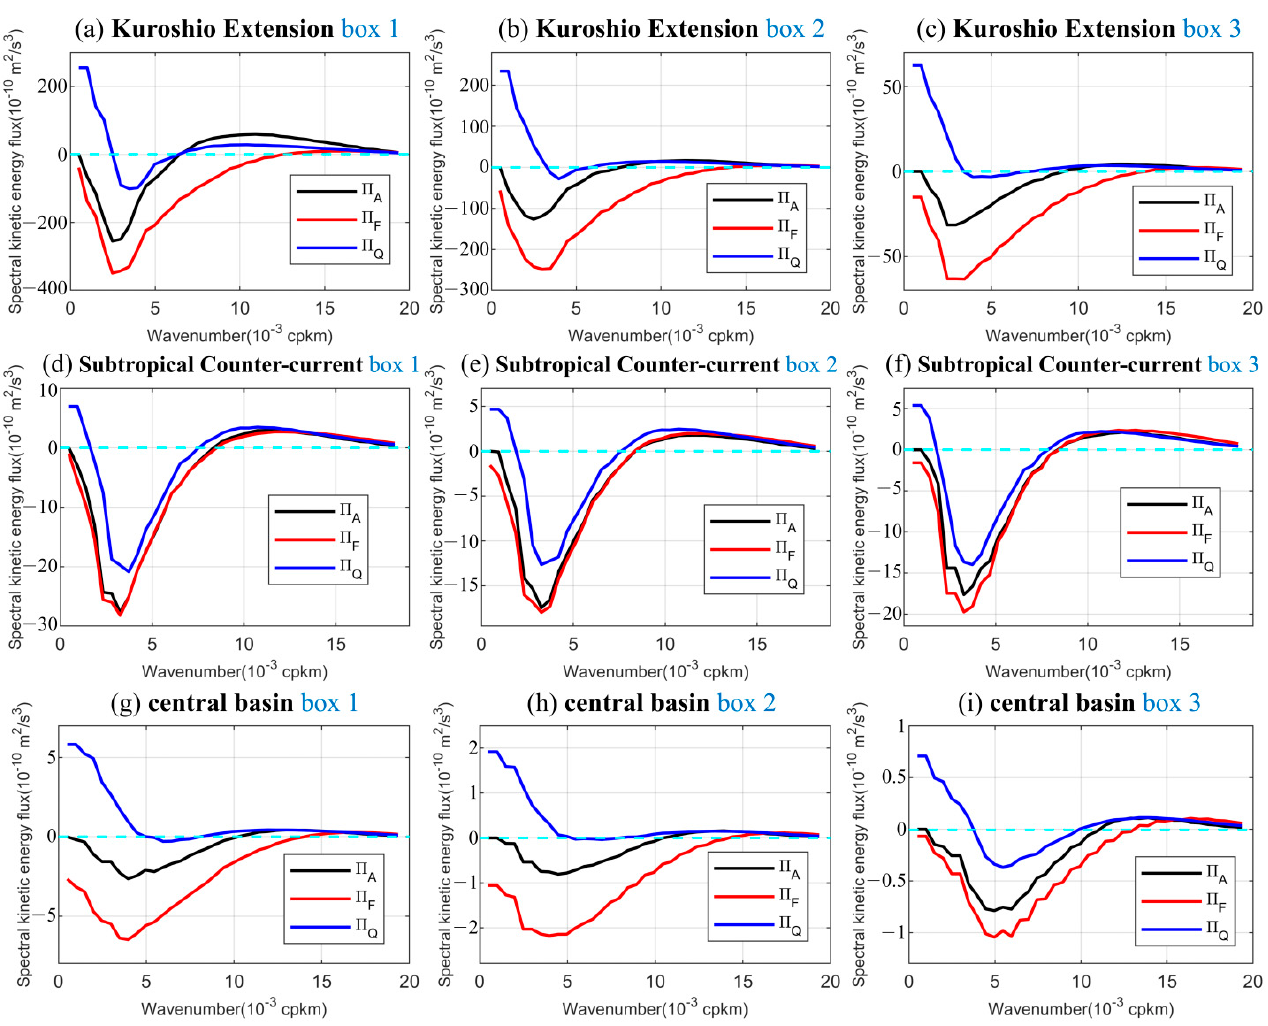
Figure 5. Time-mean surface spectral kinetic-energy flux Π A , Π F , and Π Q in the nine subregions marked in Figure 2. Each box has 40 × 40 grid points. Results here are estimated from the original velocity data without